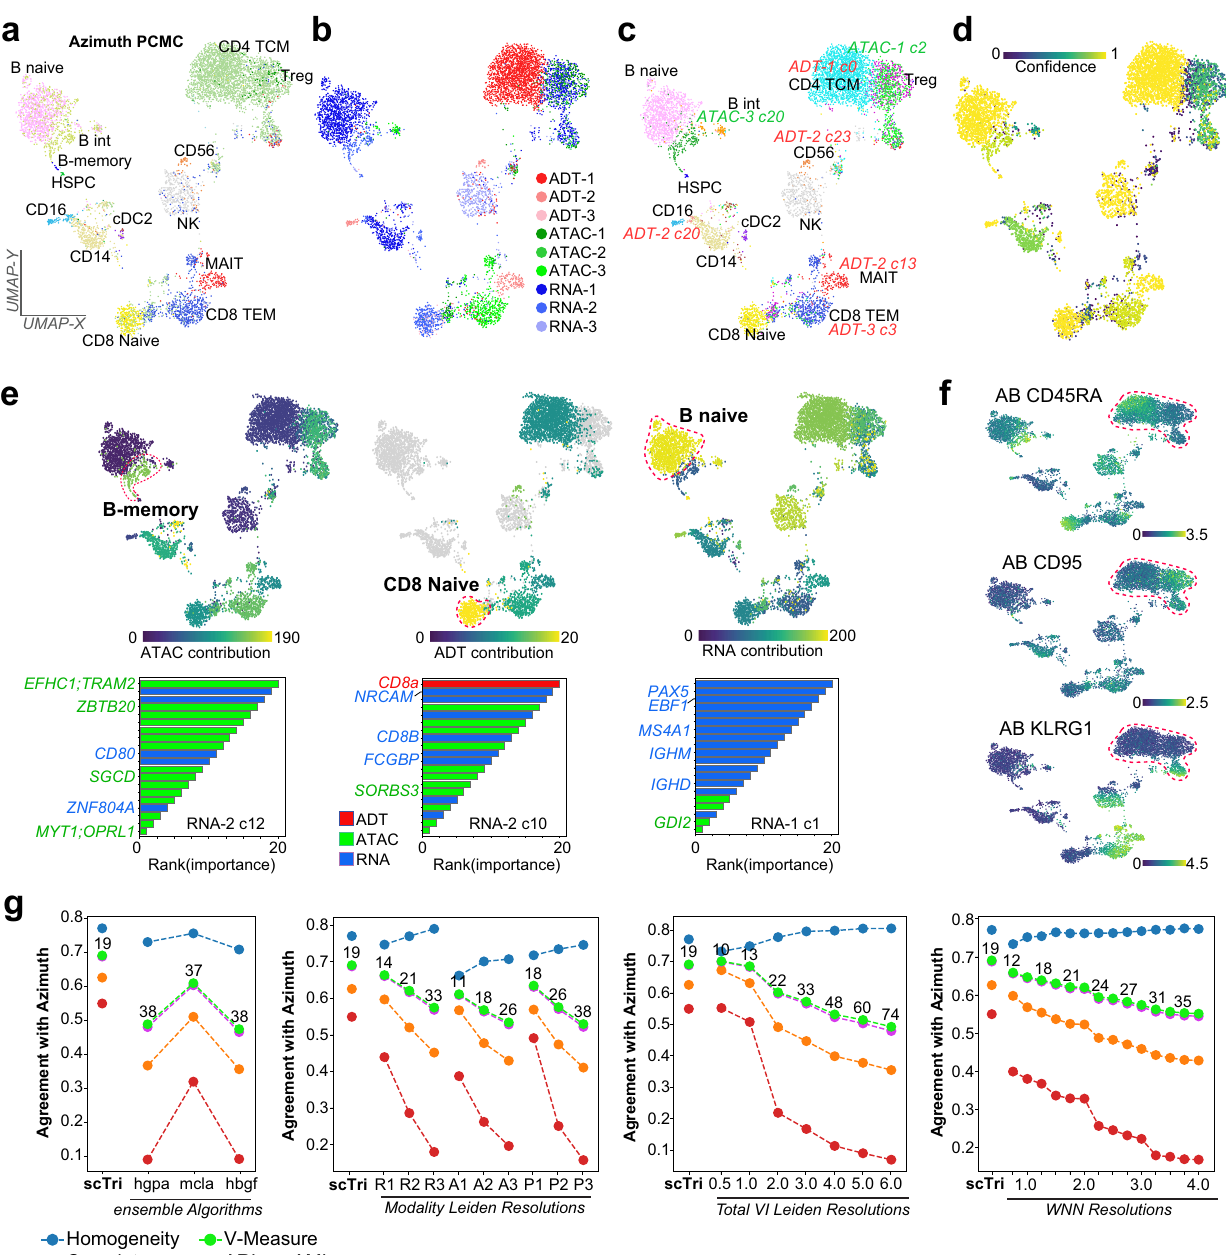
with example features denoted. f) Unannotated T-cell subsets evidenced by cell- surface ADTs. g Agreement with Azimuth PBMC reference label assignments measured by Homogeneity, Completeness, and V-Measure, for each individual or integrated set of clustering solutions (single-modality Leiden, multimodal Seurat WNNorTotalVI,ensembleclustering).Ensembleclustering wasperformed using 9 independentLeidenclusteringresultsderivedfromthethreeindependentTEA-Seq modalities (RNA, ATAC, and ADT), using three popular consensus algorithms; HyperGraph Partitioning Algorithm (HGPA), Meta-Clustering Algorithm (MCLA) andHybridBipartiteGraphFormulation(HBGF).Thenumberofclustersproduced by each indicated resolution is displayed above the V-Measure. Source data are provided as a Source Data fi